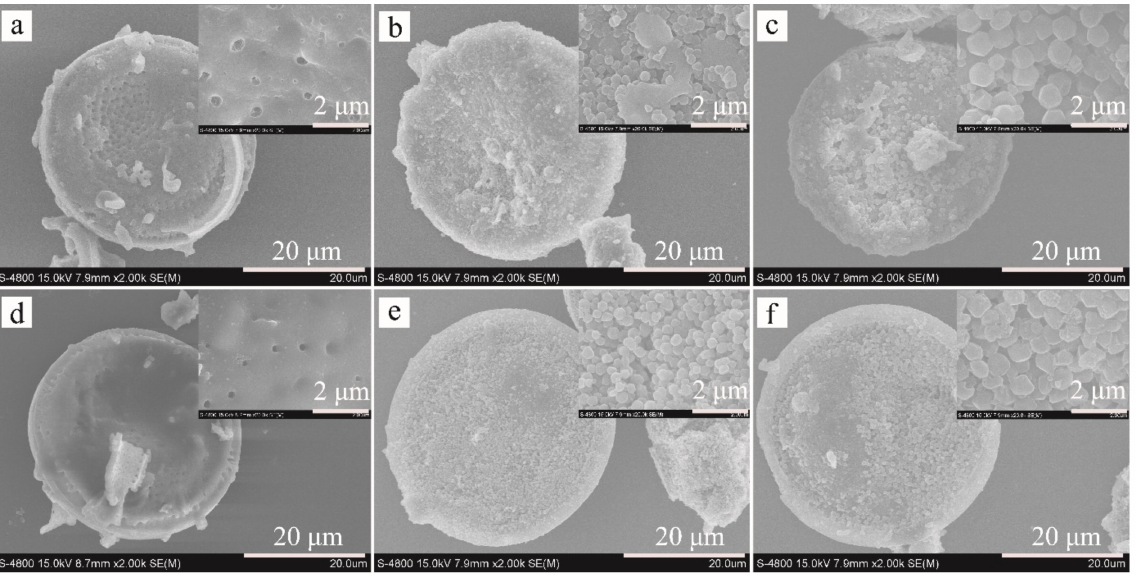
Figure 2. SEM images of ( a – c ) ZIF-8@Dt-COOH(1 × ) and ( d – f ) ZIF-8@Dt-COOH(2 × ) with Zn 2+ concentrations of 0.04, 0.08 and 0.12 mmol/mL (2000 × and inlets, 20,000 ×